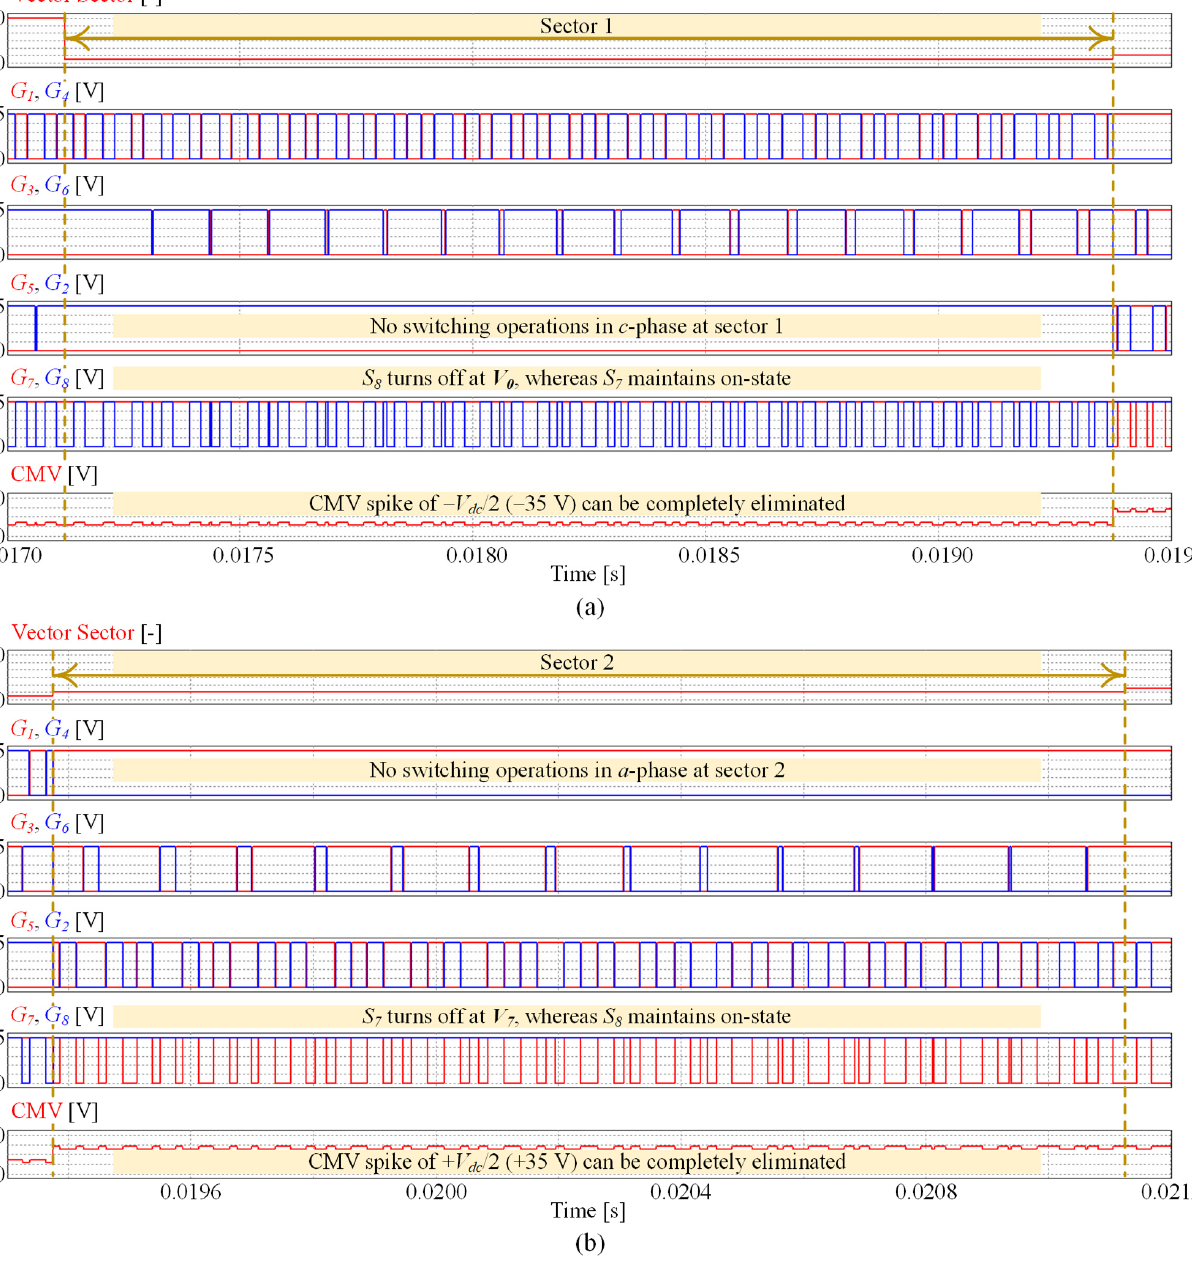
Figure 14. Simulation results of gating signals in proposed method: ( a ) Sector 1; ( b ) Sector 2.